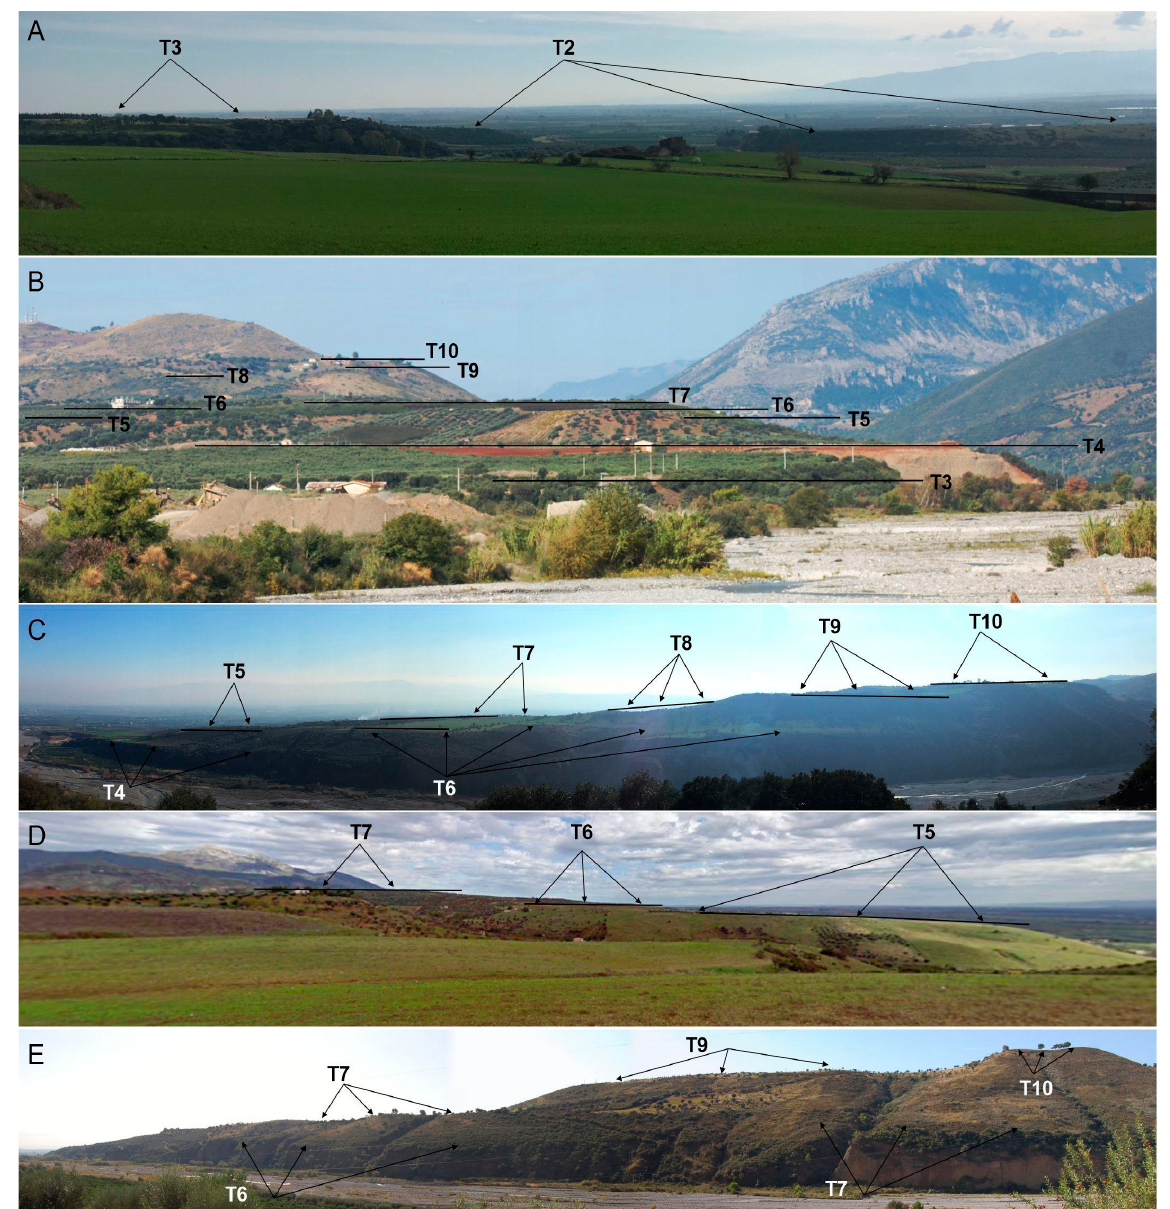
Figure 4. Overview of landscapes in the study area; arrows indicate terrace order. ( A ) View from the west of the Doria ridge inset into terrace T3. ( B , C ) The T. Raganello river valley shows amazing views of most of the stepped flight of terraces; it is worthy to note the telescopical arrangement of terraces. ( D ) View from the west (Timpone Rosso) of the terrace flights on the left side of the Eiano river. ( E ) Overview of the oldest terraces (T6–T10) characterized by clear cross-cut relationships on the right side of the T. Raganello river.